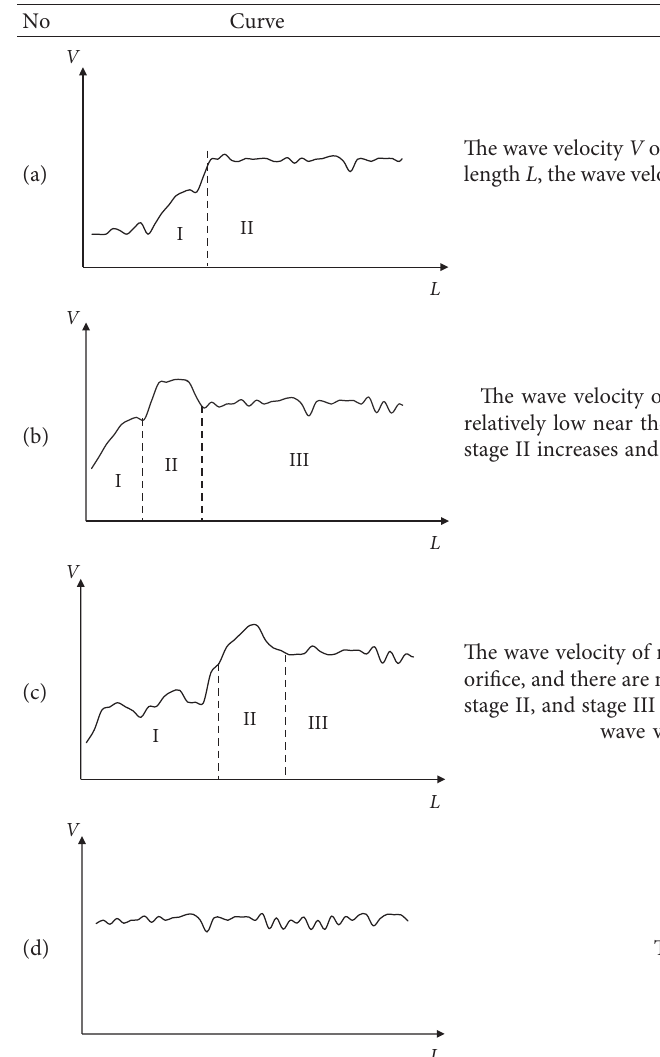
Table 1: Typical V - L curves according to the results of practical engineering